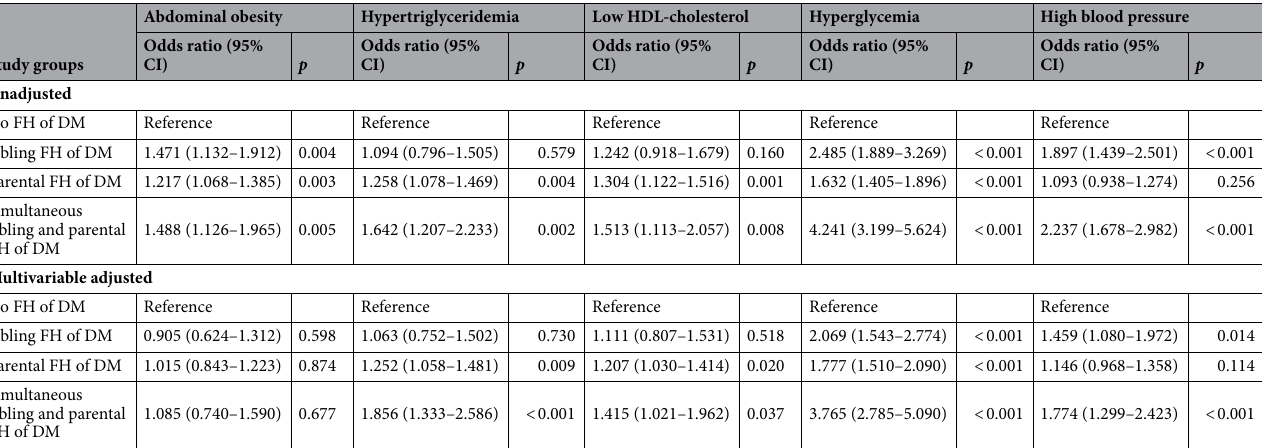
Table 3. Relation of study groups to each MetS components using multivariable logistic regression analysis. Values expressed as odds ratio, hazard ratio and 95% confidence interval (CI). Abbreviations are the same as in Table 1. Multivariable model: adjusted for study groups of FH of DM, age, sex, smoking history, BMI, hemoglobin, eGFR, uric acid, regular exercise and midnight snack